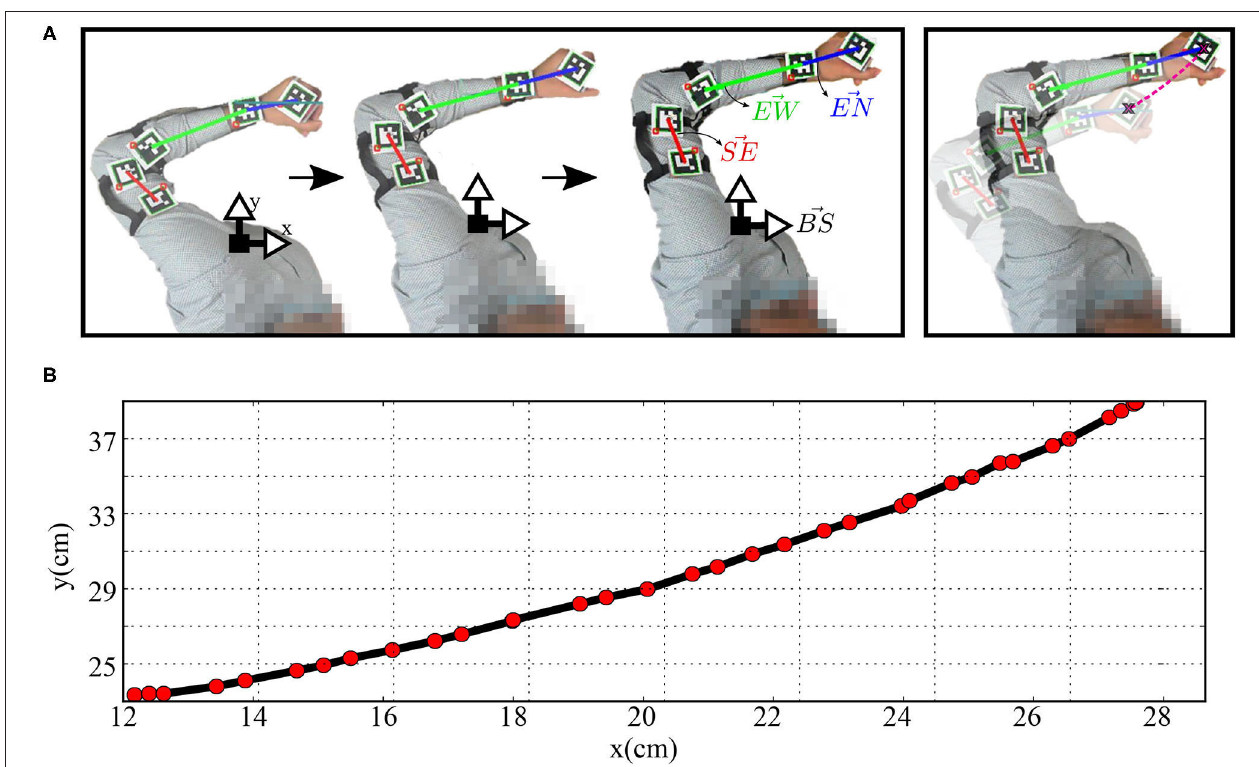
FIGURE 8 | (A) The human arm while moving in straight paths and (B) the plot of the Cartesian position of the hand-held object while moving.